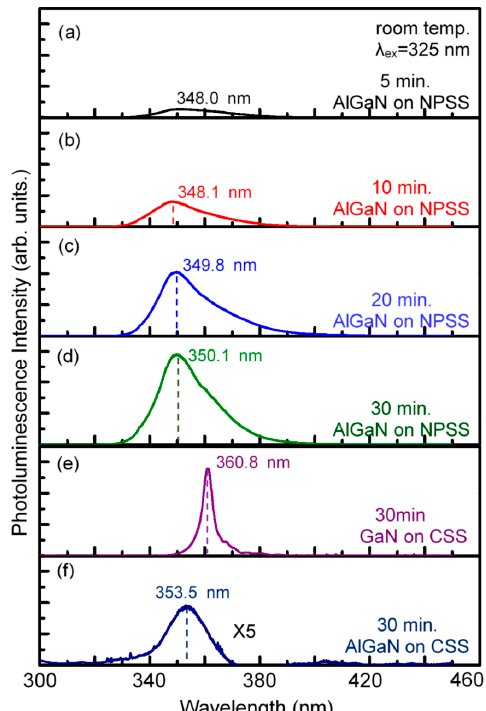
Figure 8. Room-temperature photoluminescence spectra of the HVPE AlGaN-on-NPSS epilayers as a function of growth time ( a ) 5; ( b ) 10; ( c ) 20 and ( d ) 30 min. The HVPE GaN and AlGaN samples on CSS for 30 min are also presented in ( e , f ) for comparison.